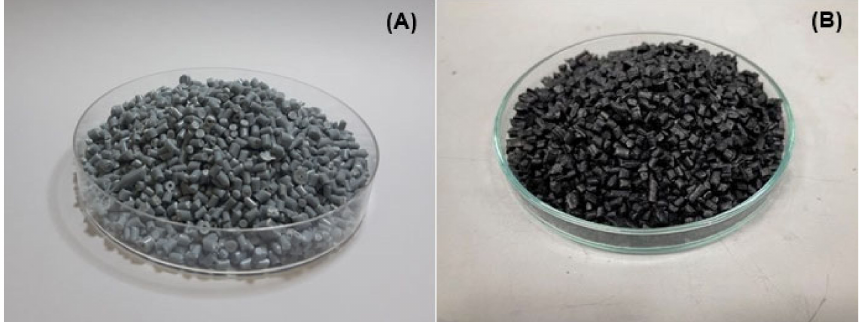
Figure 6. Optical images of pellets of compound ( A ) rPP30 and ( B ) rPP30 composited with carbon black.